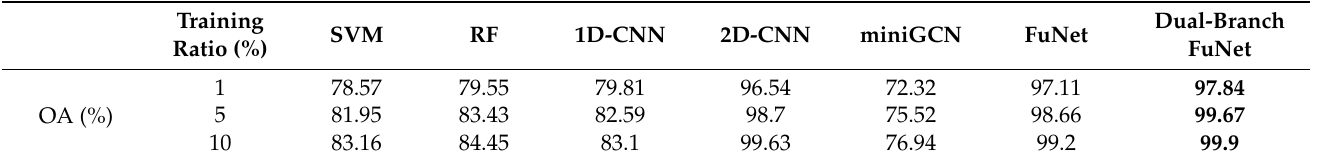
Table 6. Classification OAs with different training ratios on AIRSAR Flevoland data. Bold numbers indicate the highest accuracy in each row.